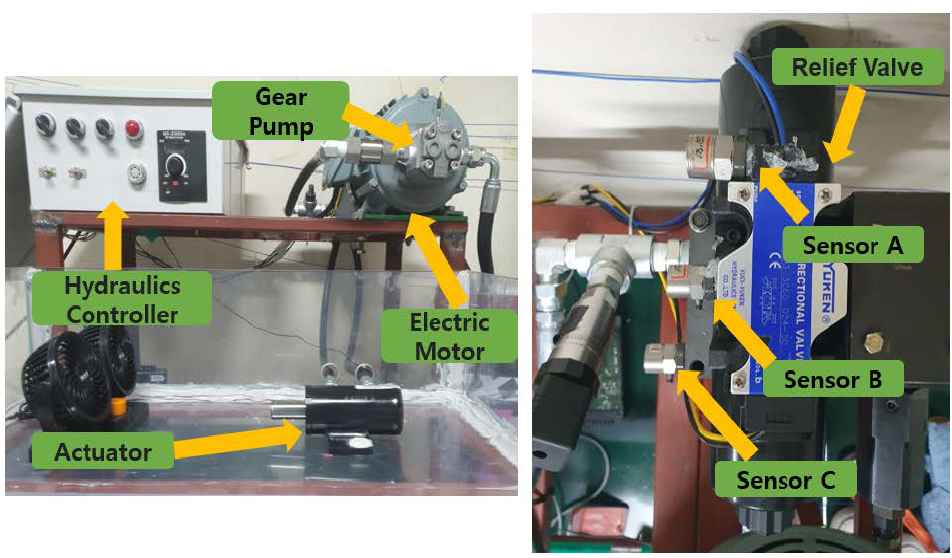
Figure 4. Test Bench Setup.